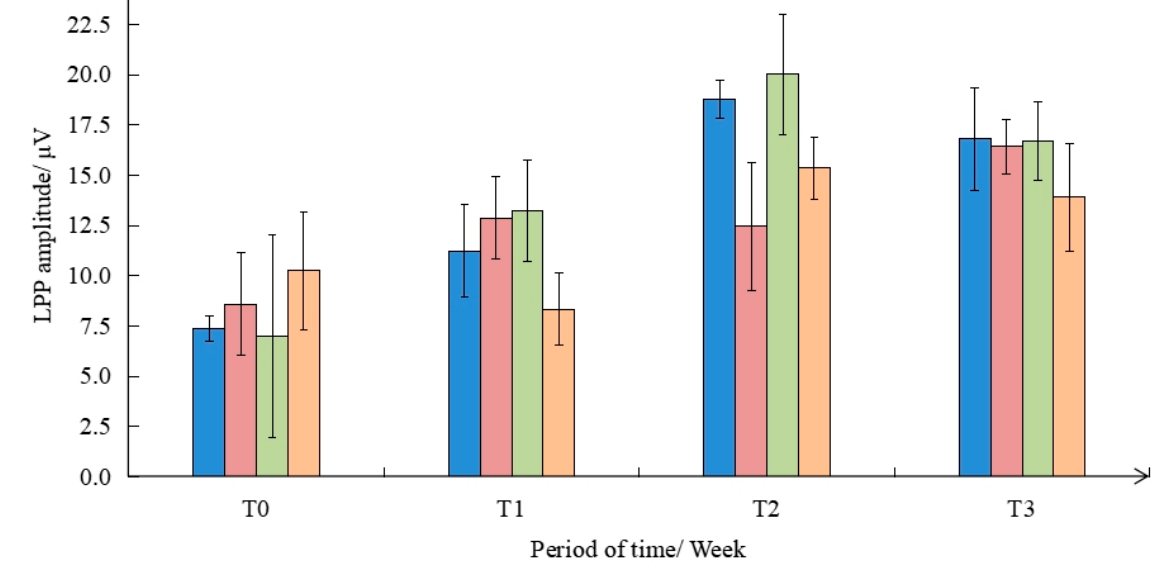
Figure 8. Comparison of P300 peaks in different groups and time periods.